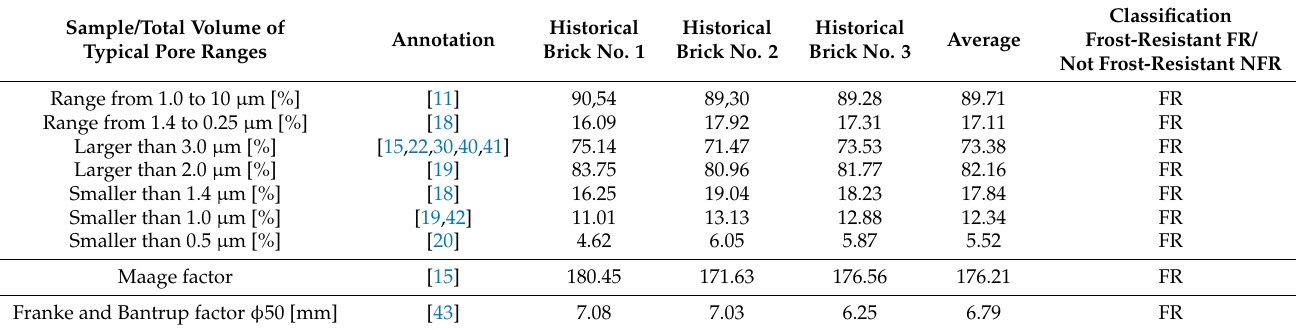
Table 7. Historical brick frost resistance prediction models.